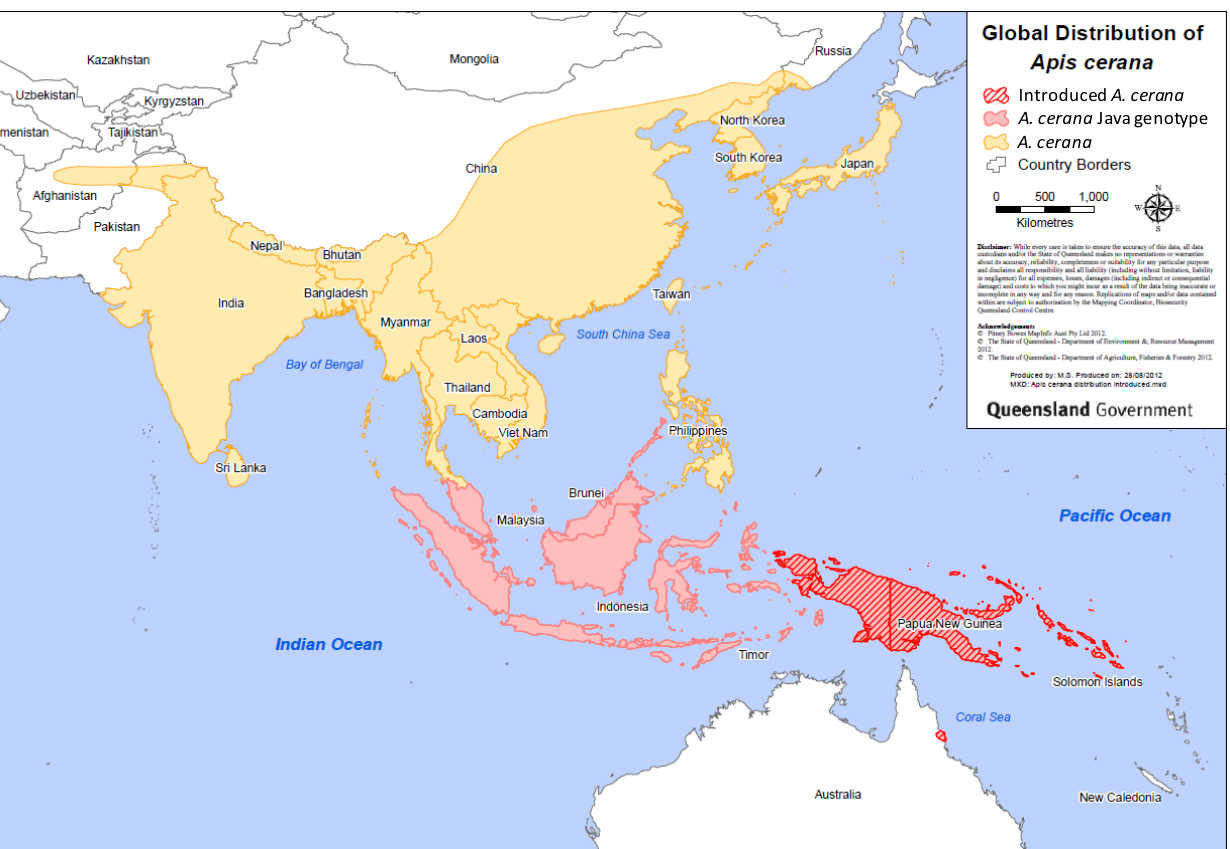
Figure 1. Distribution map of Apis cerana (cid:86)(cid:75)(cid:82)(cid:90)(cid:76)(cid:81)(cid:74)(cid:3)(cid:87)(cid:75)(cid:72)(cid:3)(cid:86)(cid:83)(cid:72)(cid:70)(cid:76)(cid:72)(cid:86)(cid:182)(cid:3)(cid:81)(cid:68)(cid:87)(cid:88)(cid:85)(cid:68)(cid:79)(cid:3)(cid:85)(cid:68)(cid:81)(cid:74)(cid:72)(cid:3)(cid:11)(cid:92)(cid:72)(cid:79)(cid:79)(cid:82)(cid:90)(cid:3)(cid:68)(cid:81)(cid:71)(cid:3) red) and its introduced range (stippled